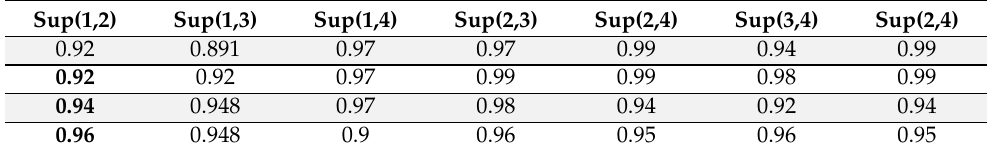
Table 14. Matrix of support values.